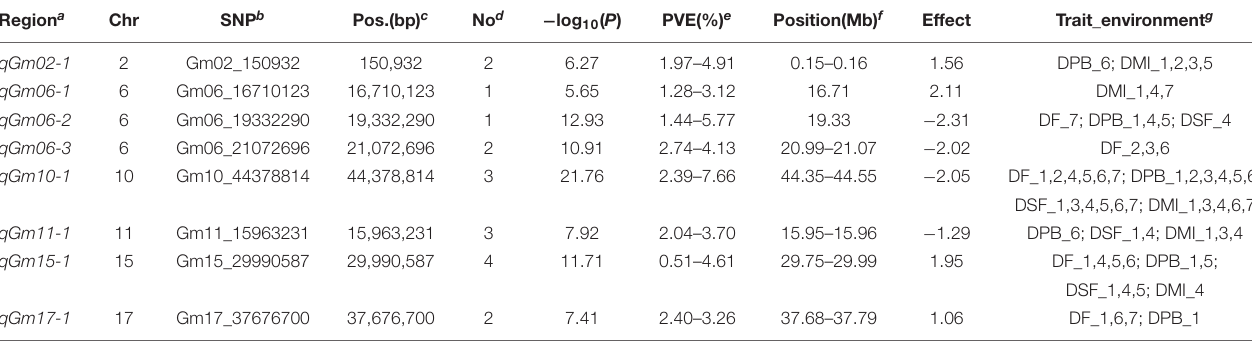
TABLE 2 | Eight QTN regions associated with four growth stage traits via FarmCPU method across different environments in summer soybean. Region a Chr SNP b Pos.(bp) c No d − log 10 ( P ) PVE(%) e Position(Mb)